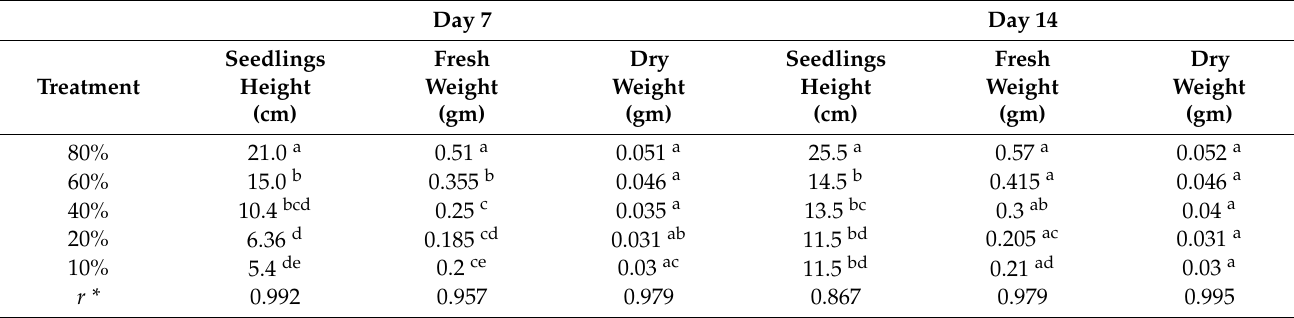
Table 2. Seedling height (cm), fresh weight, and dry weight (gm), and water content (%) of pea ( Pisum sativum L.) in response to soil water holding capacity levels: 80%, 60%, 40%, 20%, and 10% grown under continuous light at 25 ◦ C for 7 days and 14 days, separately. Means followed by different letters are significantly different ( p ≤ 0.05) by LSD; r = correlation